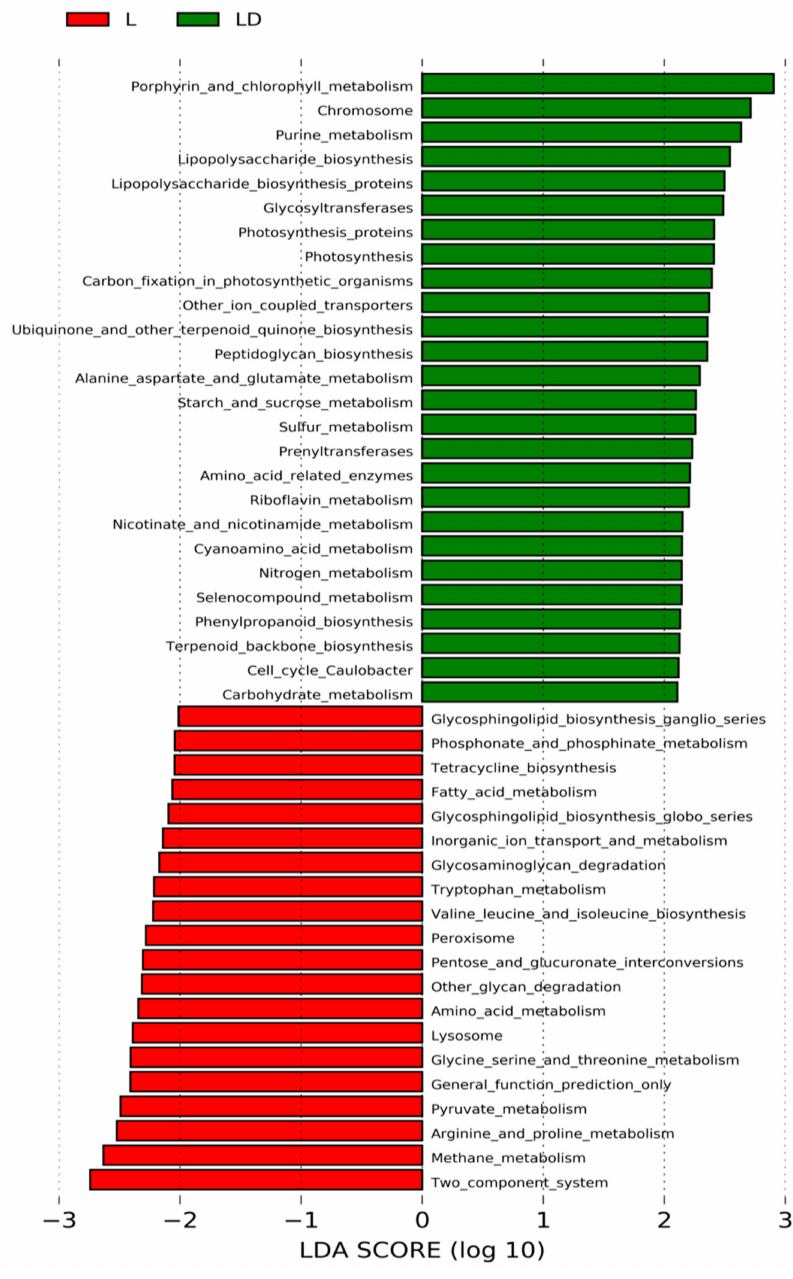
Figure 5. Comparative functional analysis through linear discriminant analysis (LDA) e ff ect size (LEfSe) of microbiota of both stages. Histogram representation of LDA scores ((log10) > 2) have been computed for di ff erentially abundant pathways between the L and LD